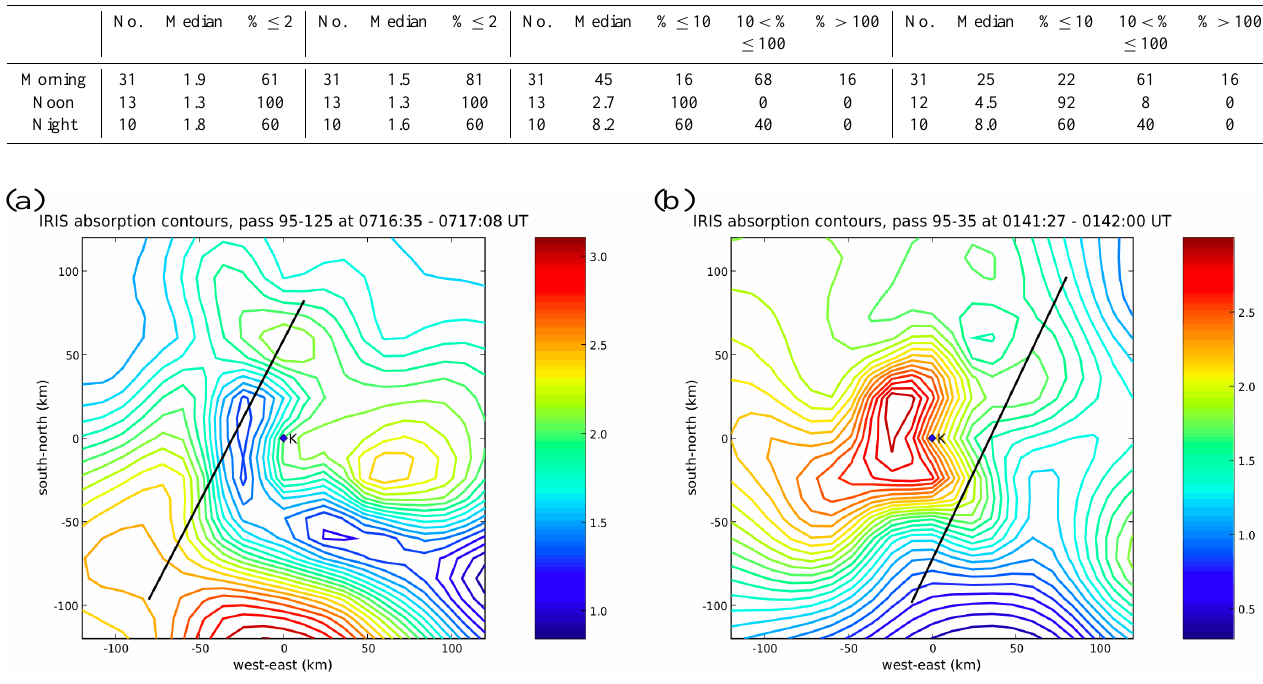
Fig. 3. The distribution of absorption (in decibels) at 90km altitude for the time of the overpasses by (a) NOAA-12 from 07:16:35 to 07:17:08UT on day 125 (5 May), and (b) NOAA-14 from 01:41:27 to 01:42:00 on day 35 (4 February), both in 1995, observed using the Kilpisj¨arvi imaging riometer. Also shown, in black, is the projected track of the satellite.